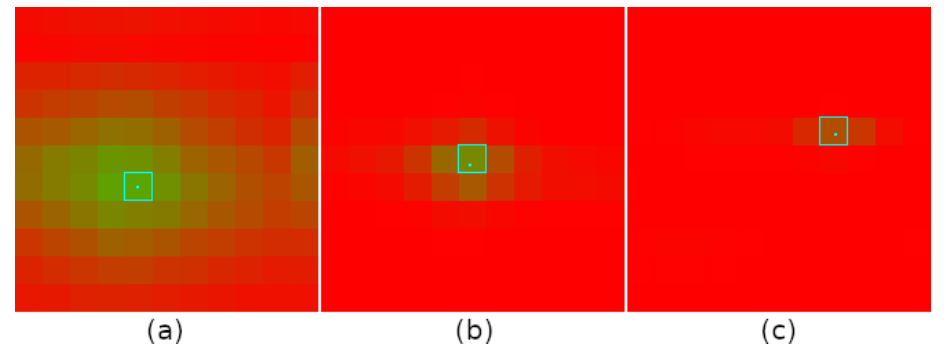
Figure 9. Grid cell module with a spacing of 0.1 ( a ), 0.3 ( b ) and 0.9 BU ( c ) (chosen within the considered variations of grid spacing [ 0.1;1 ] ), in the context given in Figure 8. With a low spacing ( a ), estimated position is very sensitive to noise. With a larger spacing ( c ), the precision of the estimated position drops as a grid cell represents a larger